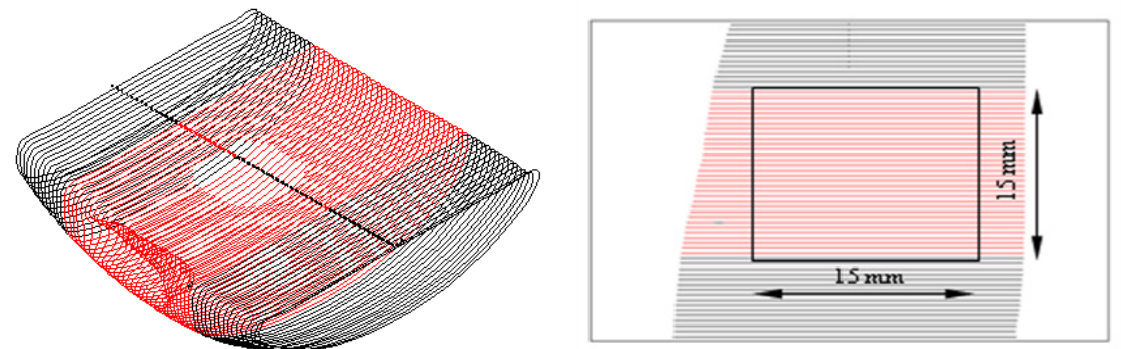
Figura 12: Sezioni realizzate per definire le caratteristiche geometriche dell’area d’interesse. Figure 12: Sections made to define the geometric characteristics of the UT scan area.